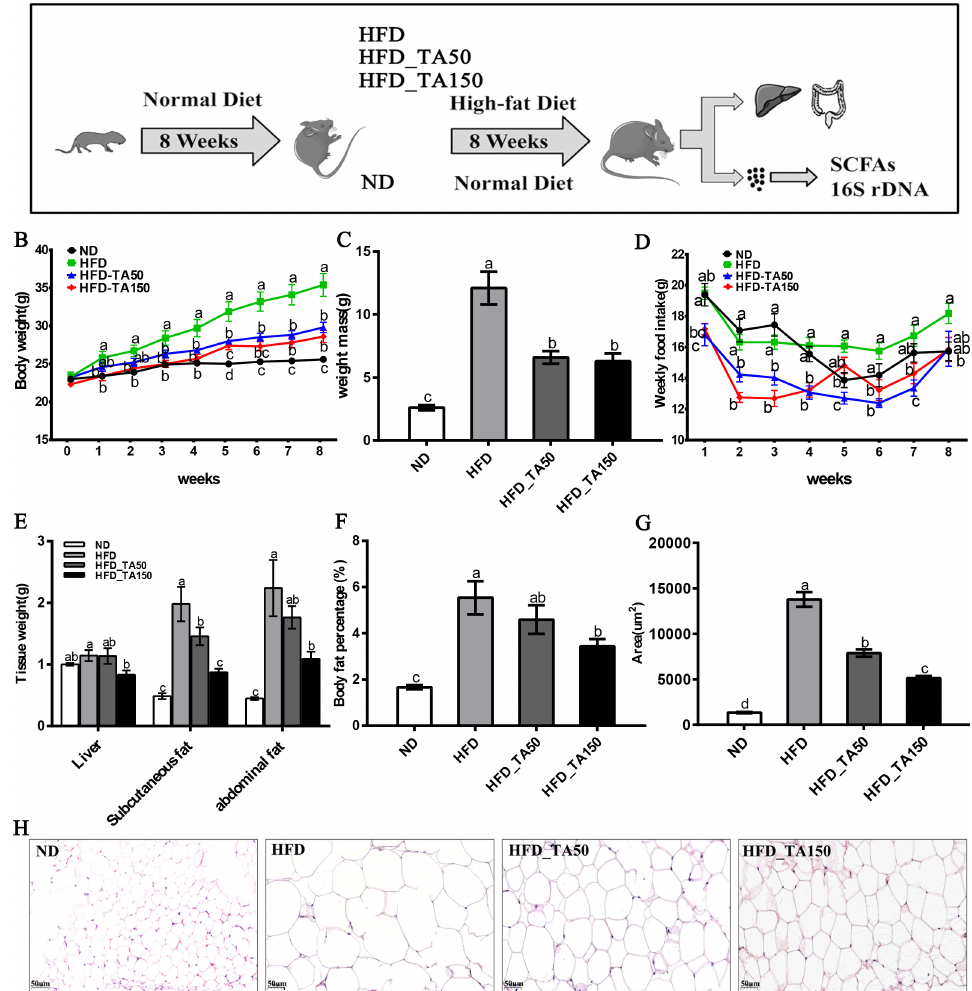
Figure 1. Effect of dietary tannic acid on body weight, fat mass and adipocyte morphology in mice induced by high-fat diet. ( A ) Timeline depicting the treatment of tannic acid, ( B ) body weight, ( C ) weight mass, ( D ) weekly food intake, ( E ) tissue weight, ( F ) body fat percentage, ( G ) lipid drops area, ( H ) epididymal adipose tissue morphology. ND: normal diet, HFD: high-fat diet, HFD_TA50: 50 mg/kg/d tannic acid intervention, HFD_TA150: 150 mg/kg/d tannic acid intervention. Data are expressed as the mean ± SEM. Different letters between any two groups indicated that there was significant difference between the two groups ( p < 0.05).